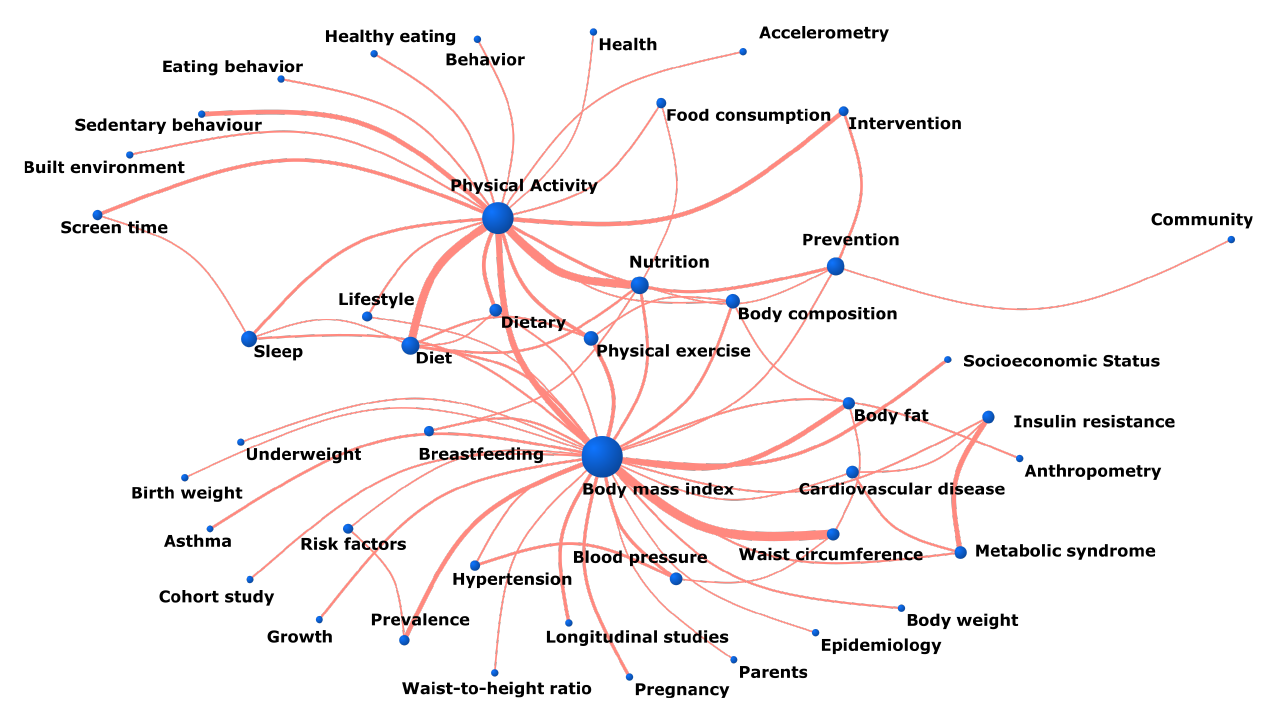
Figure 5. Network of cowords Figure 4. Keyword clouds by continent. Figure 4. Keyword clouds by continent.